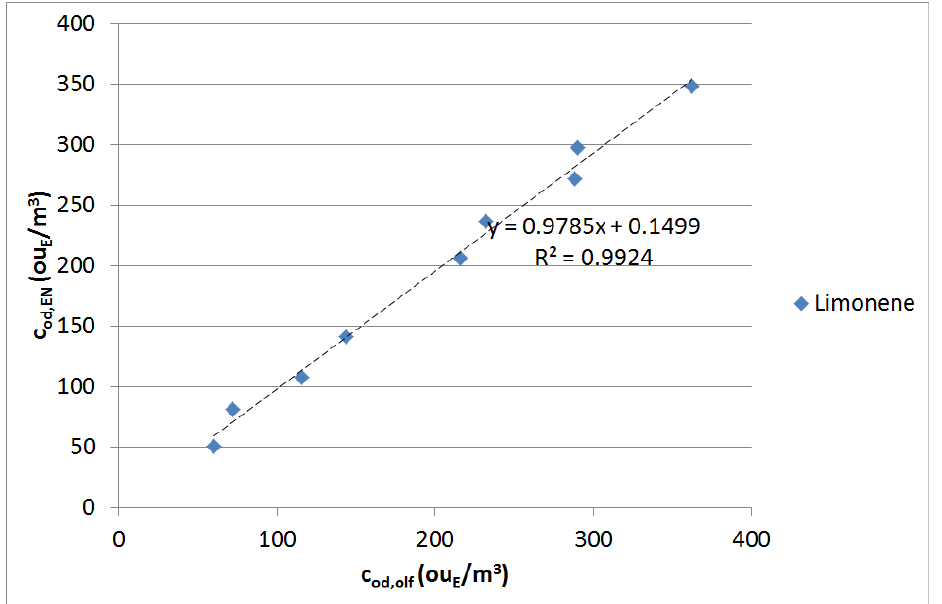
Figure 6. Estimated vs. real odour concentration of the limonene